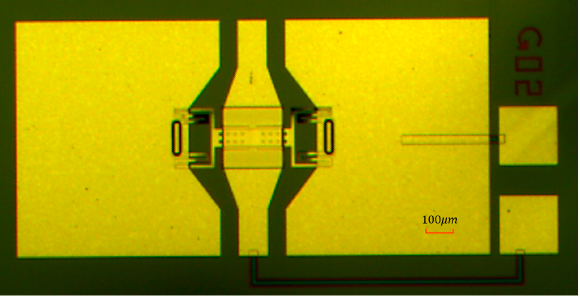
Figure 6. The top view photograph of the proposed high OFF/ON capacitance ratio RF MEMS switch.